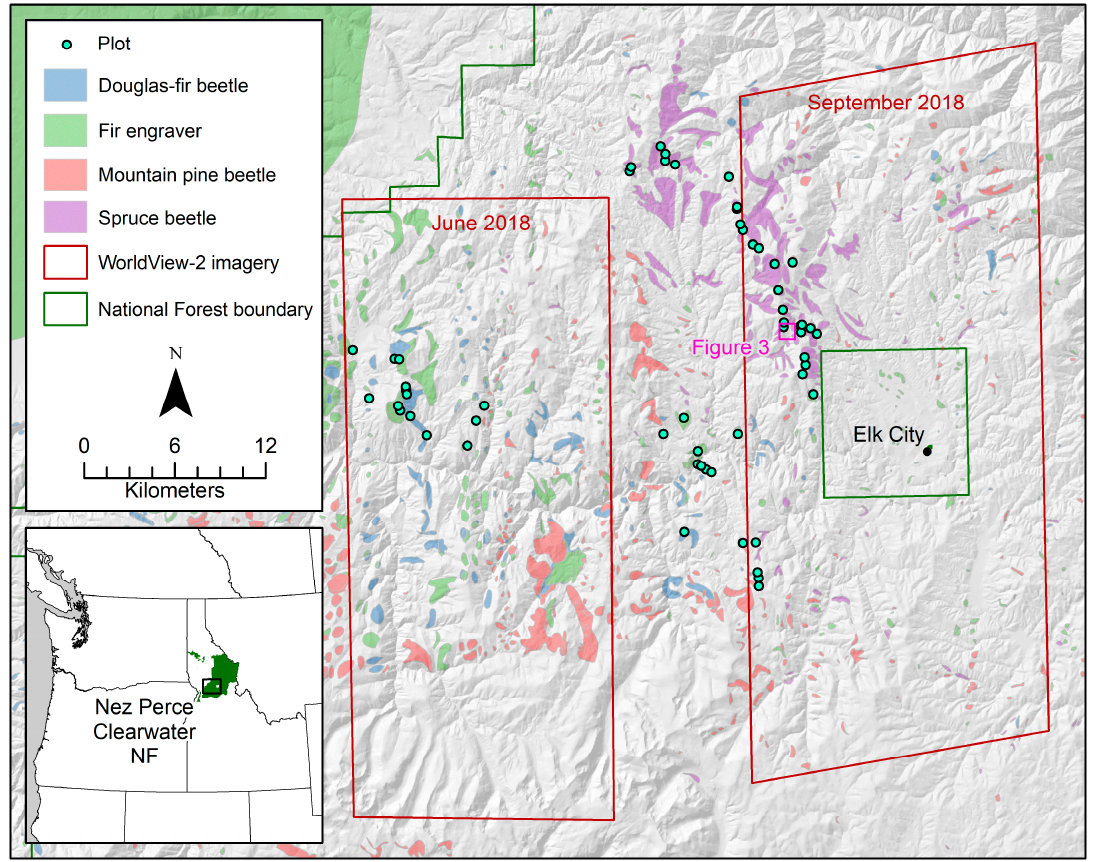
Figure 1. Study area showing WorldView-2 image extents, 2017–2018 insect and disease survey (IDS) polygons, and field plot locations on National Forest lands in central Idaho. The township surrounding Elk City is not National Forest land.